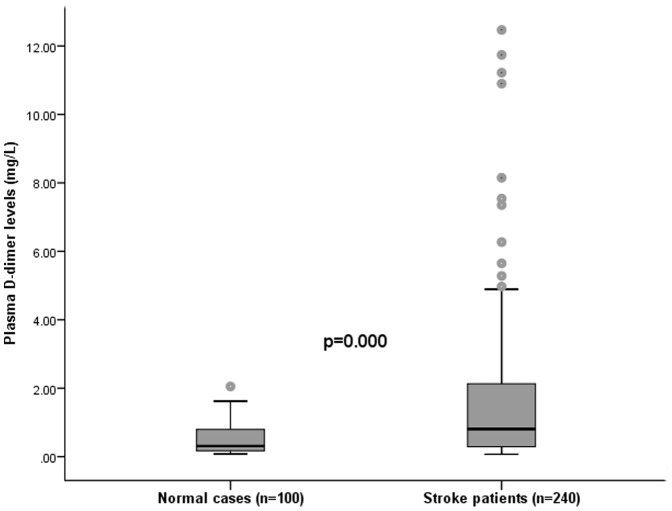
Plasma D-dimer levels in acute ischemic stroke patients and control group.Mann–Whitney U-test. All data are medians and interquartile ranges (IQR). Significantly higher in stroke patients as compared to those in normal cases (p = 0.000).